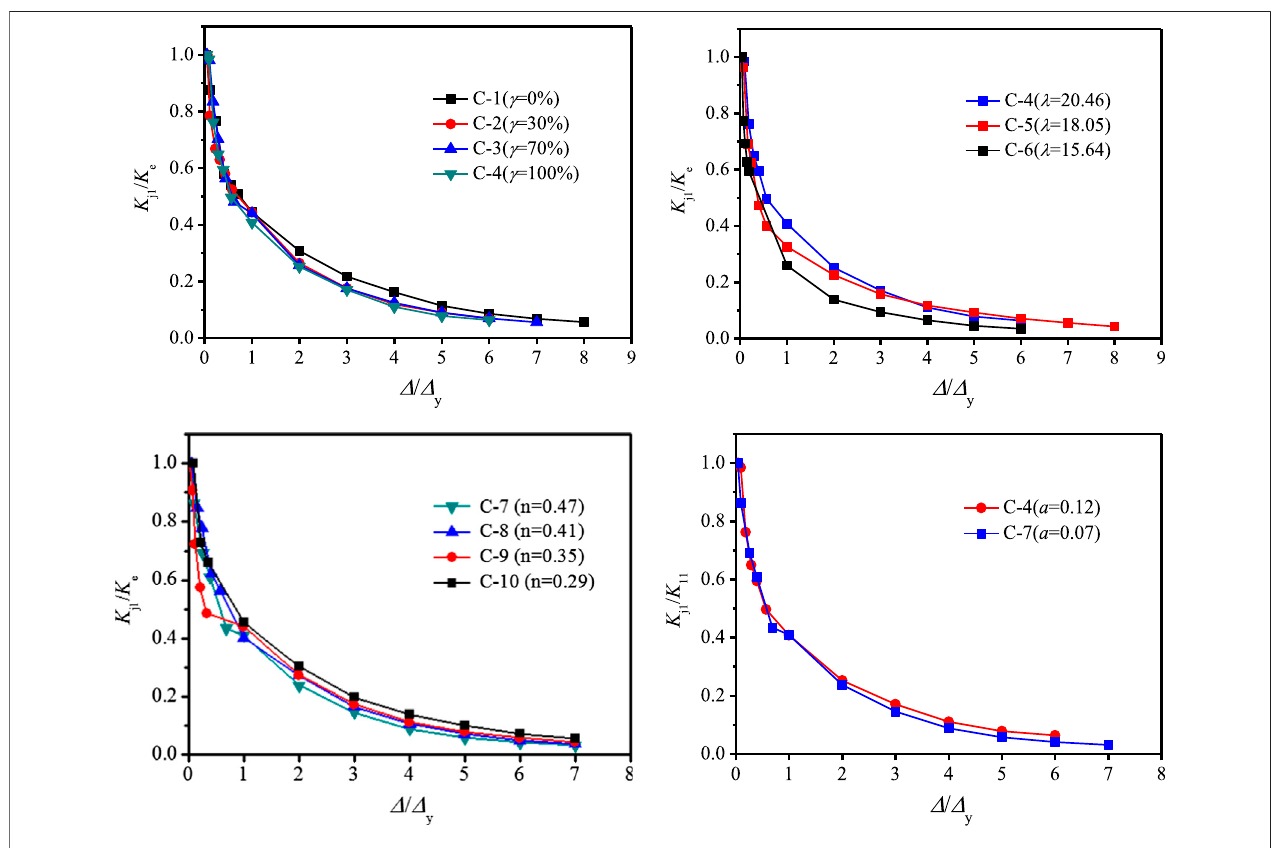
FIGURE 10 | Uniformization analysis of stiffness vs. displacement.